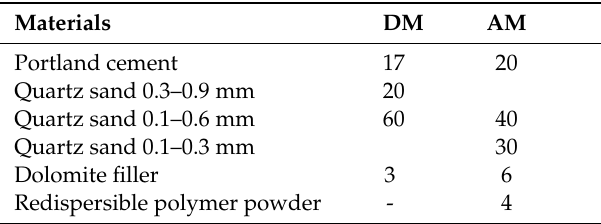
Table 1. Composition of the tile mortar (in wt%).